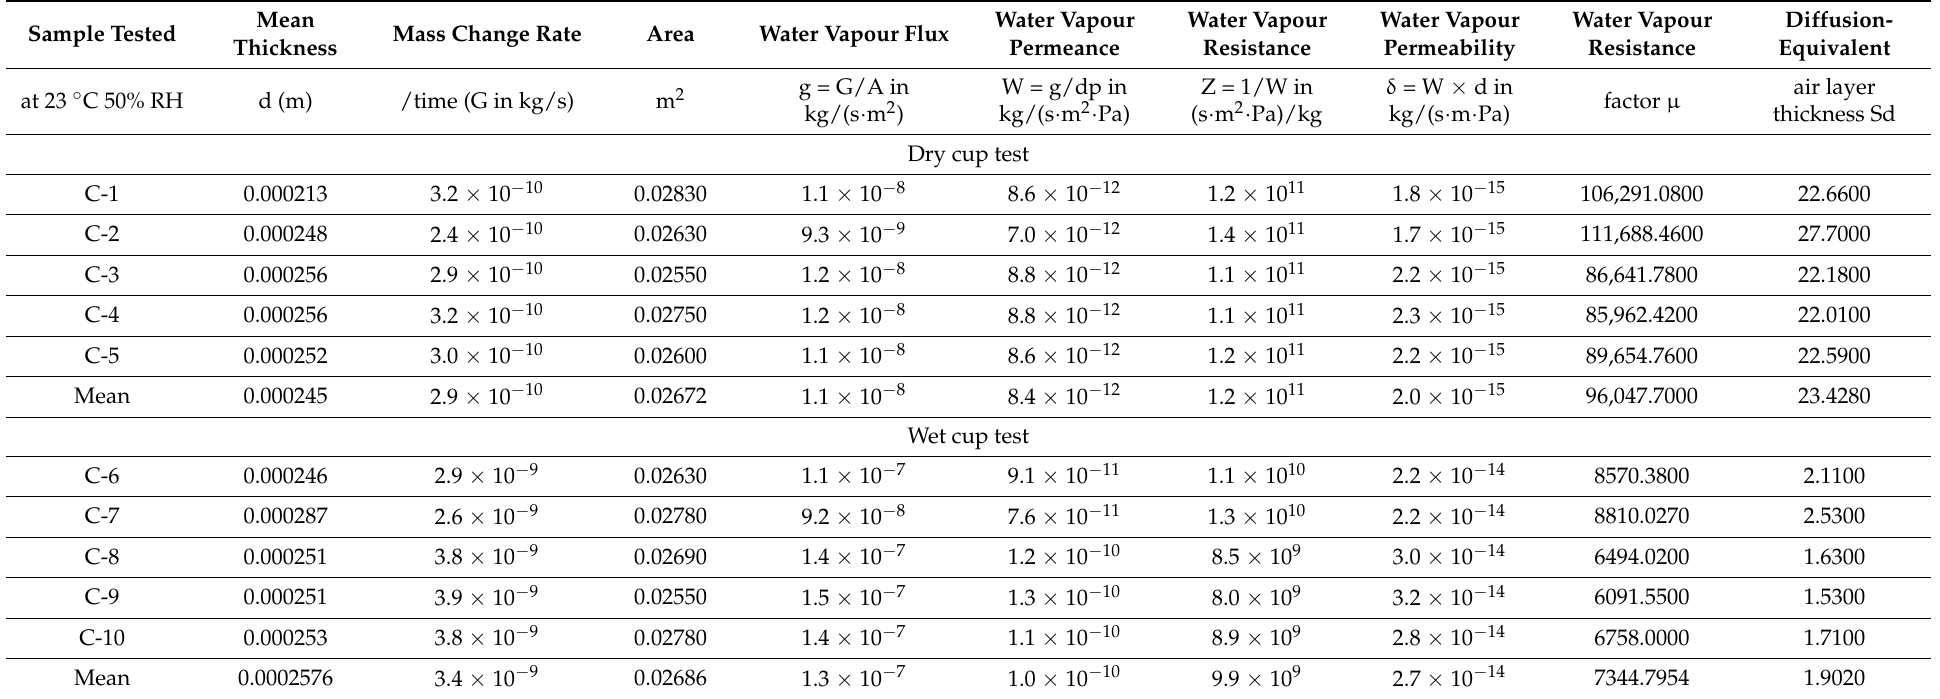
Table A3. Water vapour resistivity properties of sample C at 23 ◦ C 50%